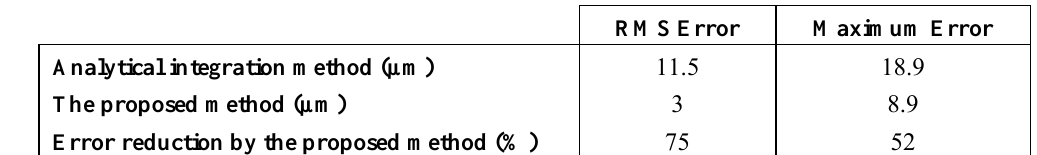
Table 4. Estimation errors obtained with the analytical integration and the proposed method.